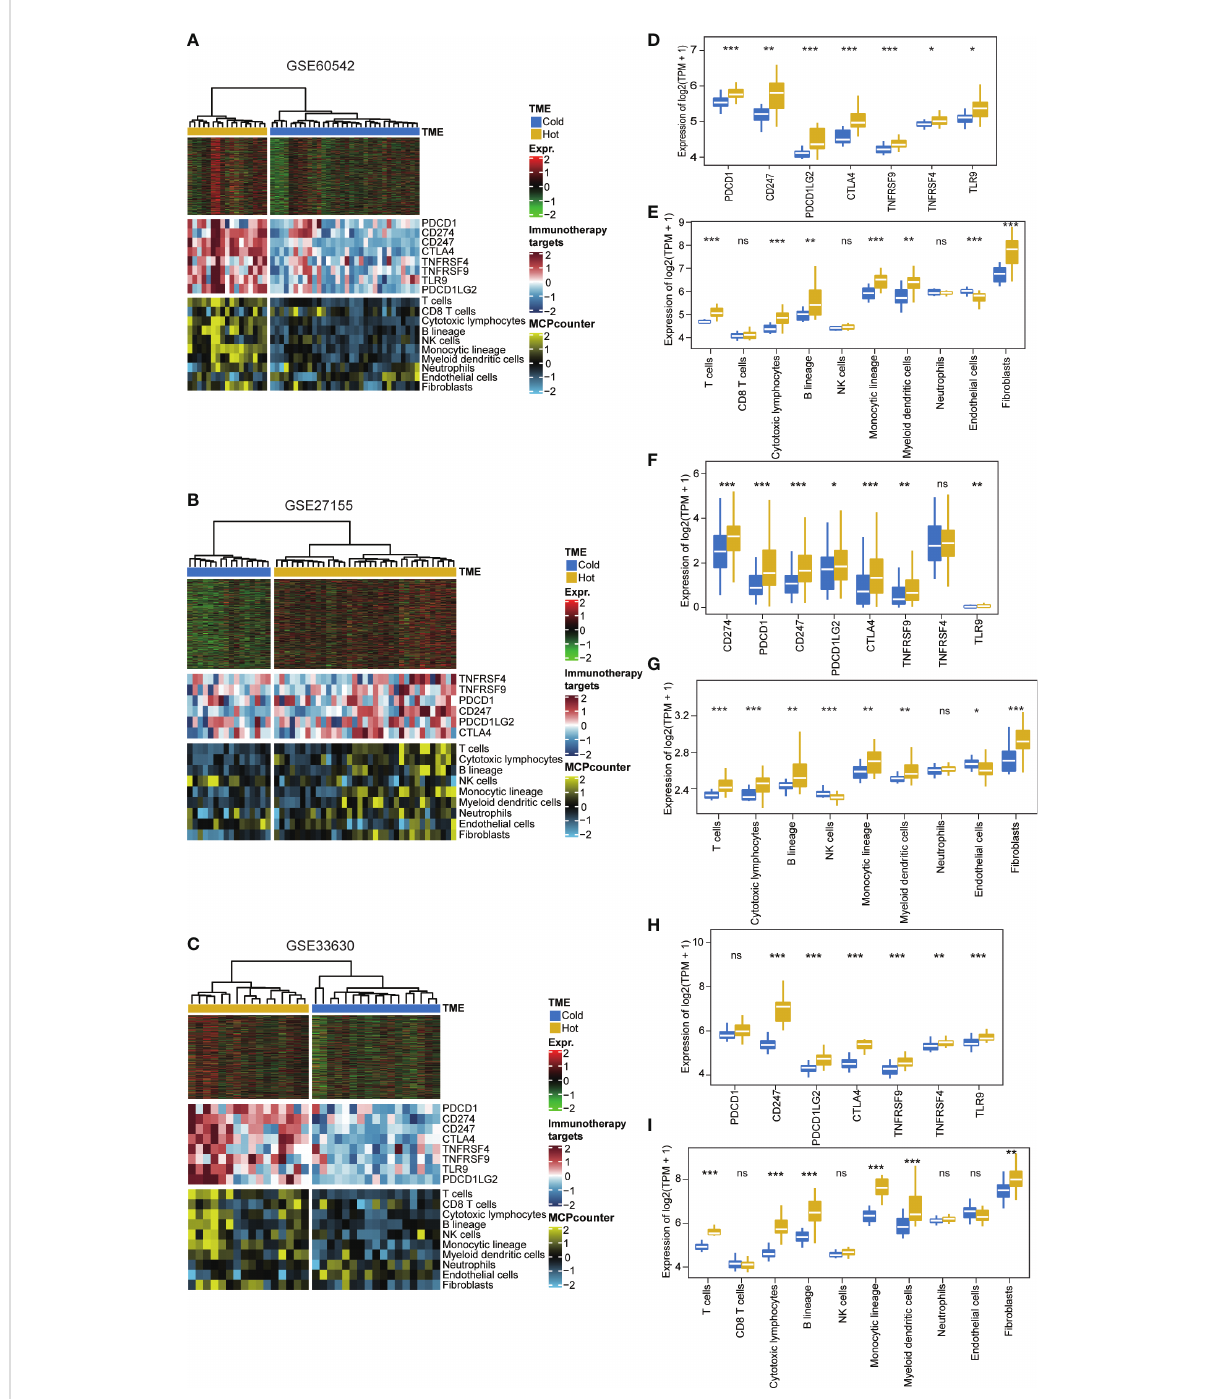
FIGURE 4 Validation of TME using supervised clustering based on 1,467 epigenetically silenced genes. The heat map showed the expression of these genes (top panel), genes representing immune checkpoint targets (middle panel), and immune and stromal cells (bottom panel) in three validation cohorts, including (A) GSE60542, (B) GSE27155, and (C) GSE33630. (D, F, H) Expression level (normalized transcripts per million) of different immune checkpoint genes in different methylation phenotypes of three validation cohorts. (E, G, I) The boxplot showed the accumulation of immune and stromal cell populations distinguished by different methylation phenotypes in the three validation cohorts. The difference was veri fi ed statistically through the Kruskal – Wallis test, and the p-values are noted with asterisks at the top of each boxplot (ns stands for no signi fi cance, *p < 0.05, **p < 0.01, ***p <